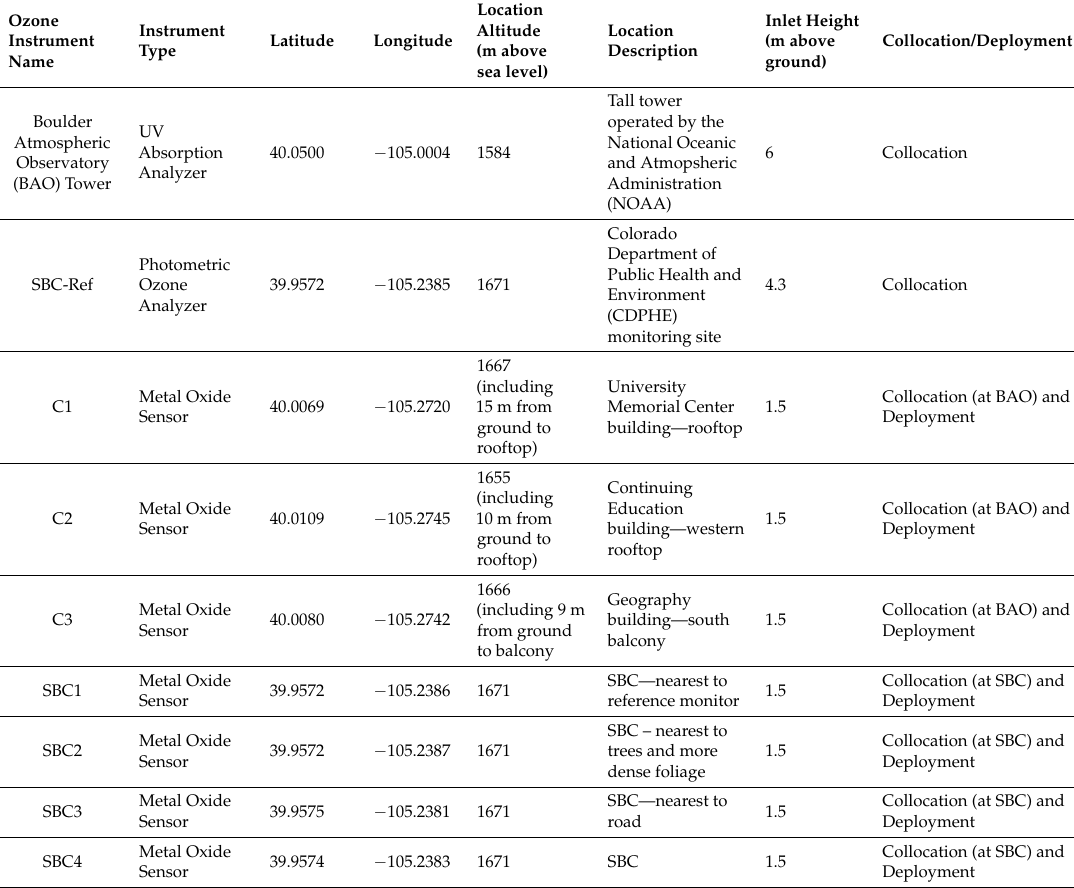
Table 1. Summary of Measurement